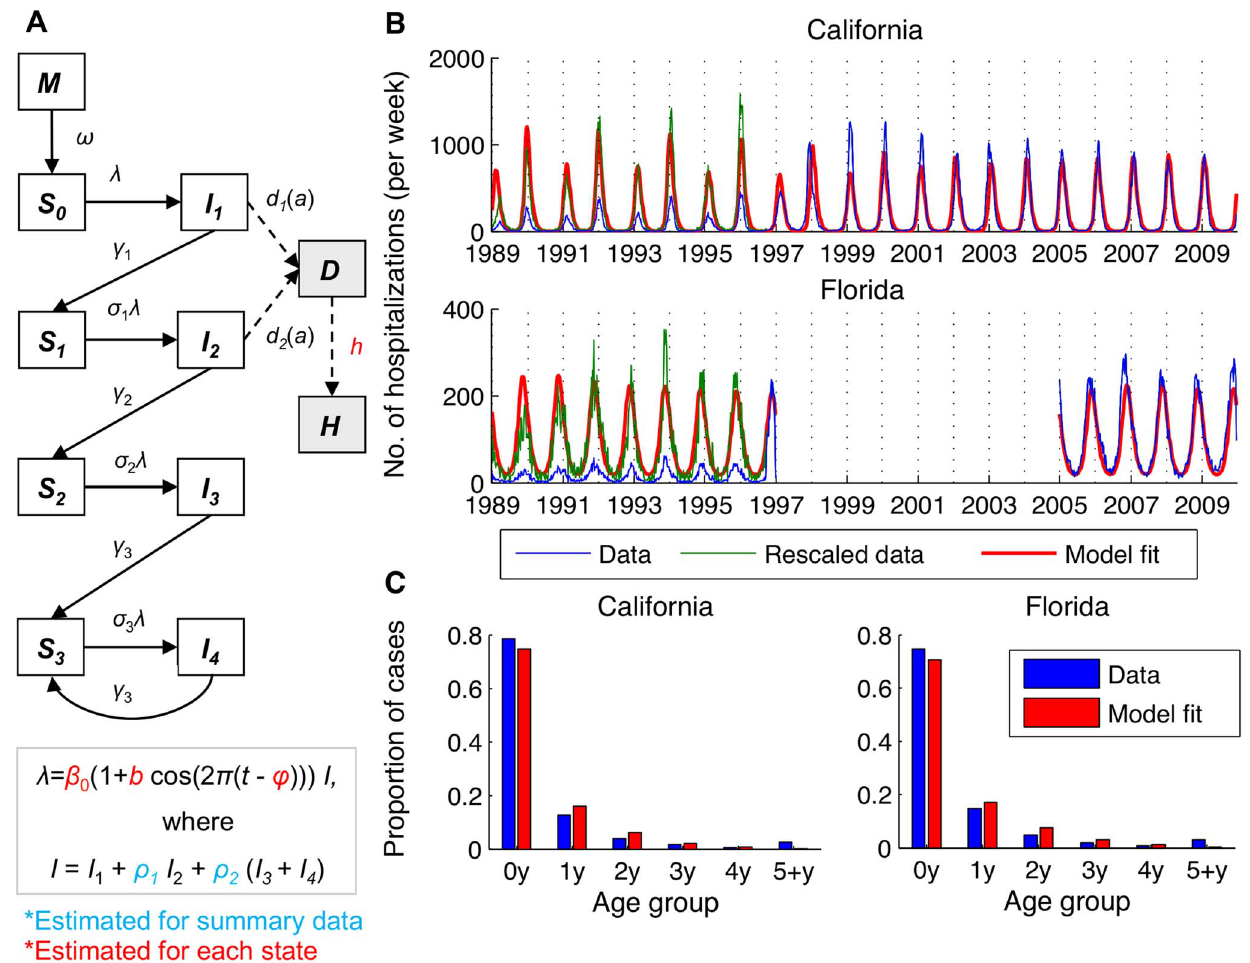
Fig. 2. Transmission dynamic model for RSV and fit to age-specific hospitalization data. ( A ) Compartmental diagram illustrating the structure of the model. White boxes represent infection states in the model, while grey boxes represent diseased/observed states (severe lower respiratory disease, D , and observed cases, H ). ( B ) Model fit to weekly RSV hospitalization data for California and Florida. The ICD9-CM coded hospitalization data is shown in blue, the rescaled data is shown in green, and the fitted models are shown in red. ( C ) Age distribution of RSV hospitalizations in California and Florida for hospitalization data and fitted models.